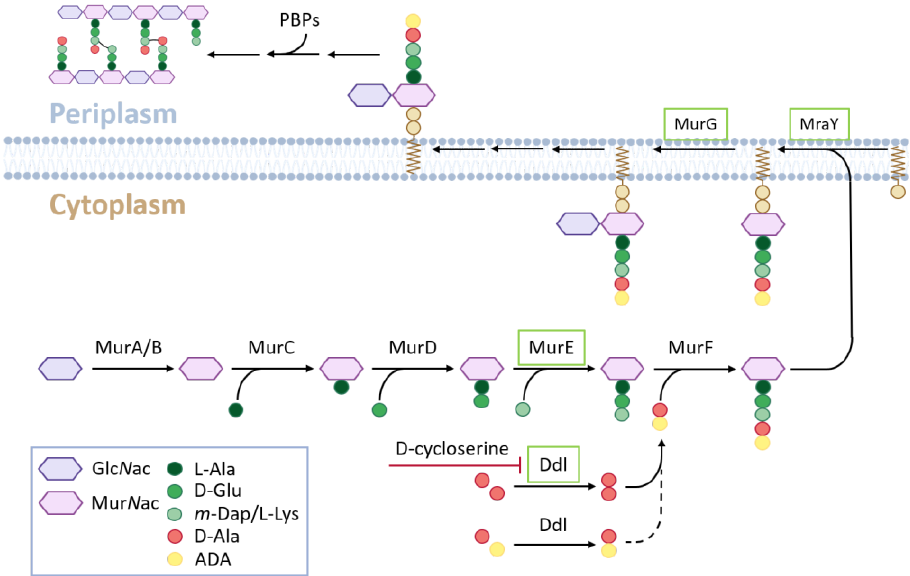
Figure 1. Principal scheme of PGN biosynthesis. Enzymes of the “4 - PGN set” are boxed in